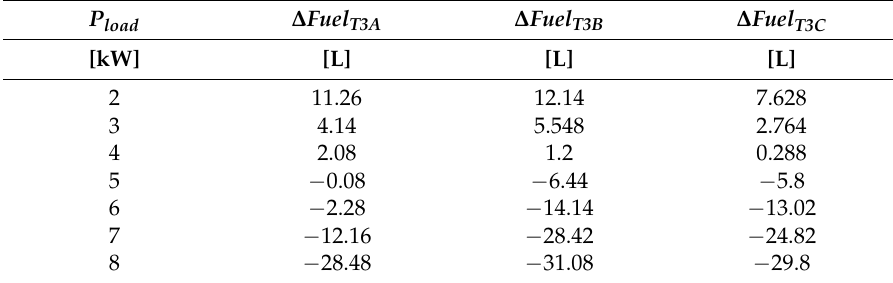
Table 7. Fuel economy for the RTO3 strategy using different k fuel